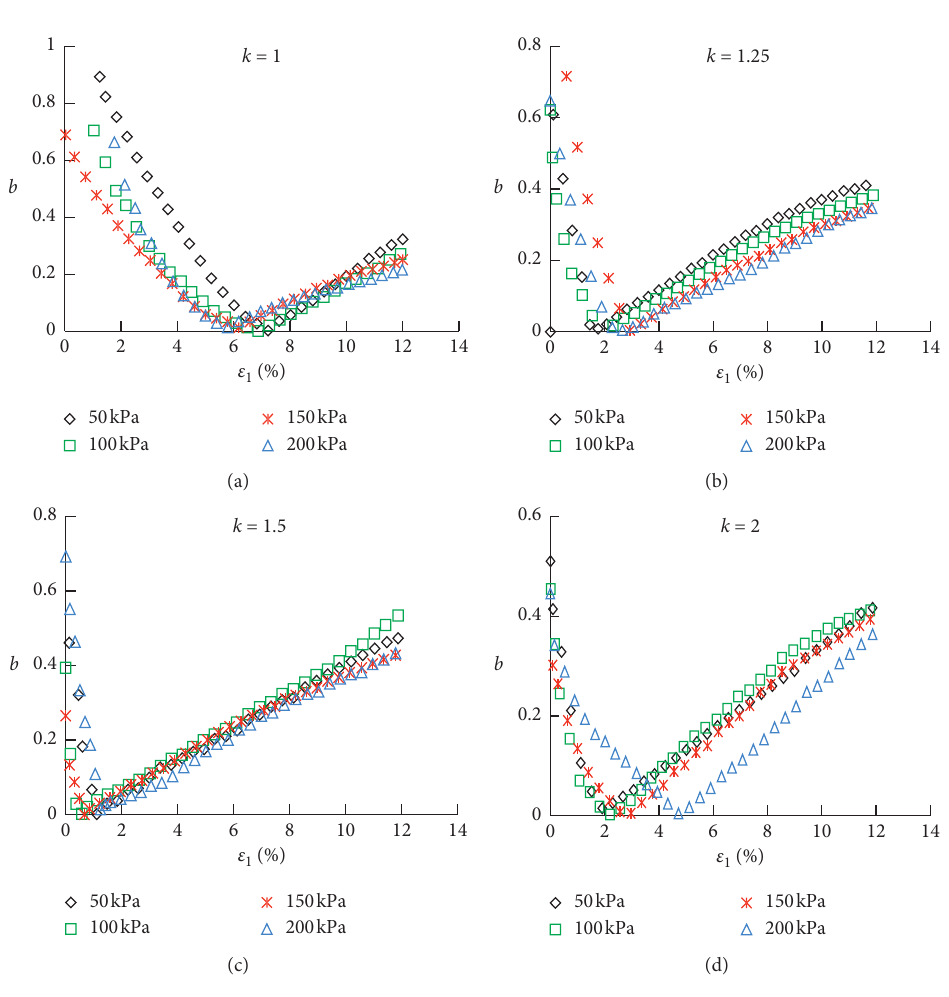
Figure 7: b ∼ ε curves of intact loess at different confining pressures. 1